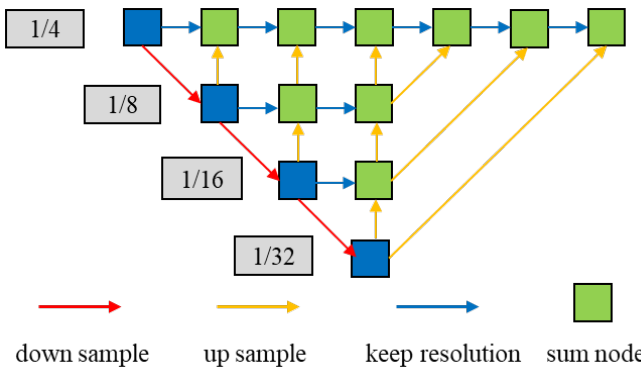
Figure 3. Illustrations of the DLA34 backbone network. The deformable convolutional layer is used for up sample instead of common inverse convolution in deep layer aggregation.